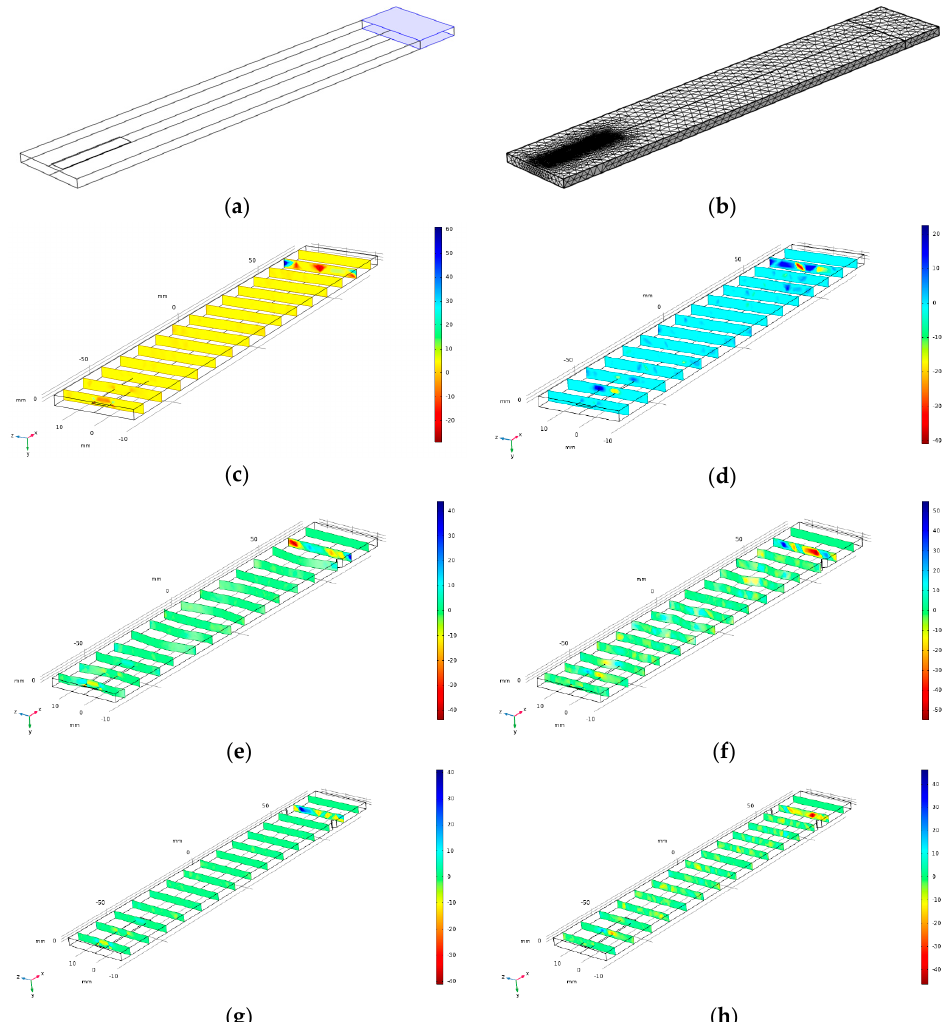
Figure 7. FEM setup and results: ( a ) Fixed constraints; ( b ) mesh., Displacements (mm) ( c ), ( d ) type-B at 47,402 and 89,994 Hz; ( e , f ) type-C1 at 47,253 and 90,038 Hz; ( g , h ) type-C2 at 47,017 and 90,064 Hz.